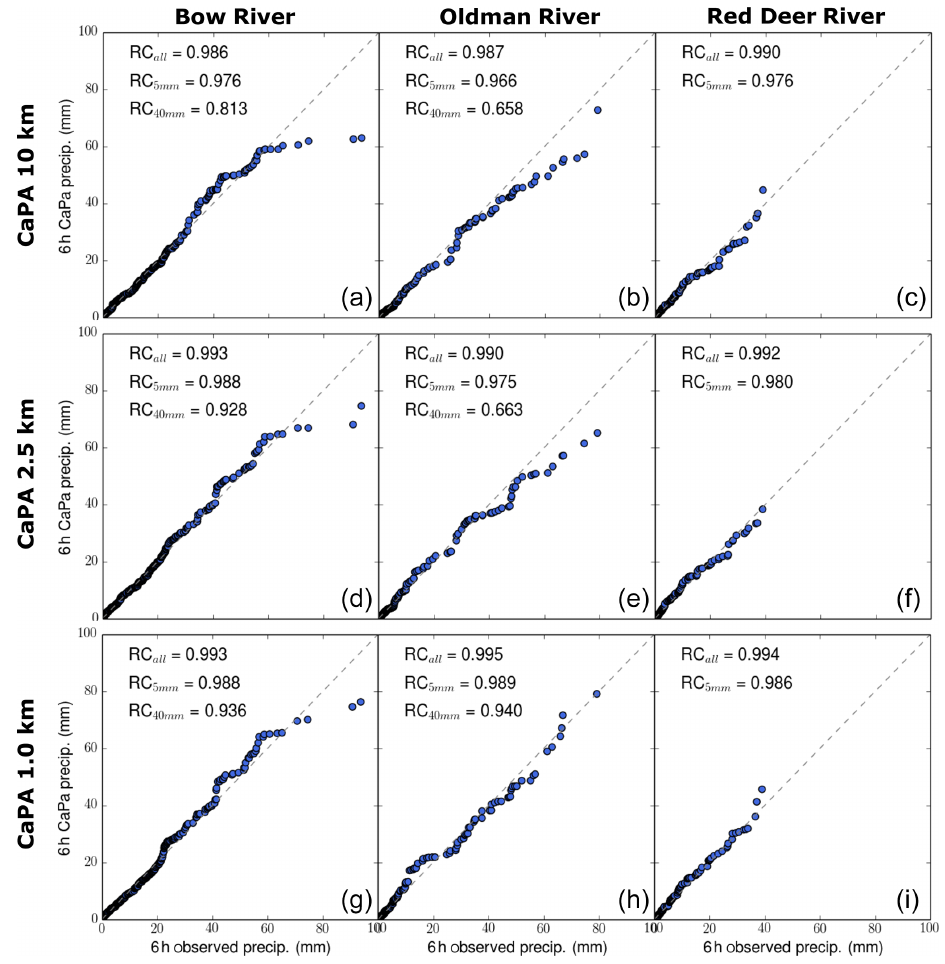
Figure 6. Quantile–quantile (Q–Q) plots between 6h observed precipitation at CRHO, COOP and ABE stations and 6h precipitation esti- mated by the leave-one-out method for the different analysis: CaPA 10km (a–c) , CaPA 2.5km (d–f) and CaPA 1km (g–i) . The Q–Q plots are computed from 19 June at 12:00UTC to 22 June at 12:00UTC for the three main river basins in the region: Bow, Oldman and Red Deer. RC represents the concordance correlation coefficient (Lawrence and Lin, 1989) computed for different categories of 6h precipitation: (i) all, (ii) above 5mm and (iii) above 40mm (see text for more